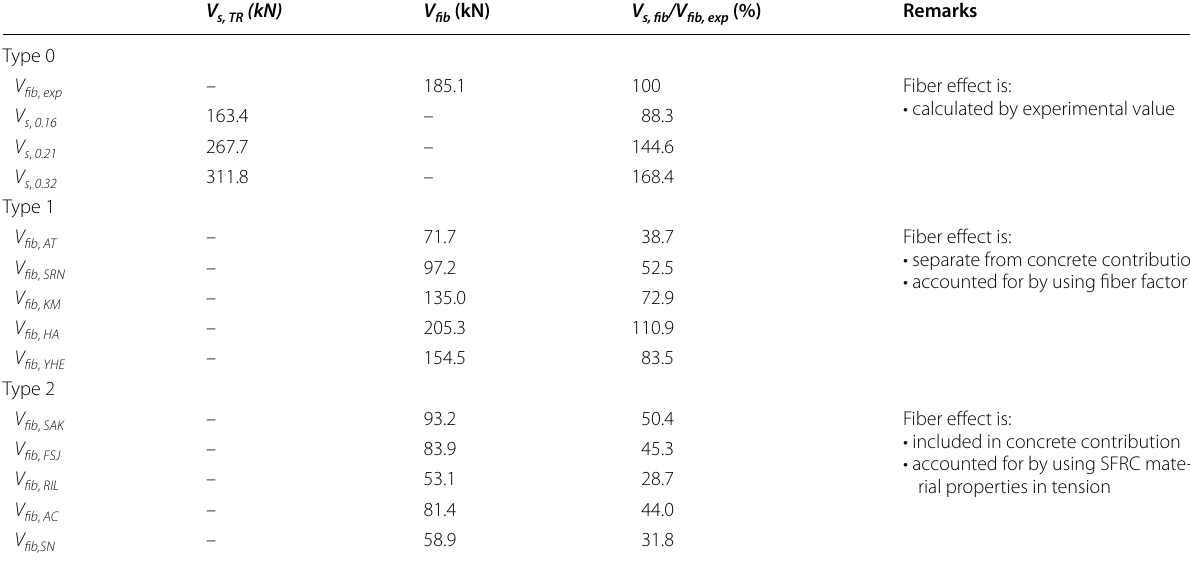
Table 10 Summary of predictions of the shear resistance of contribution of steel